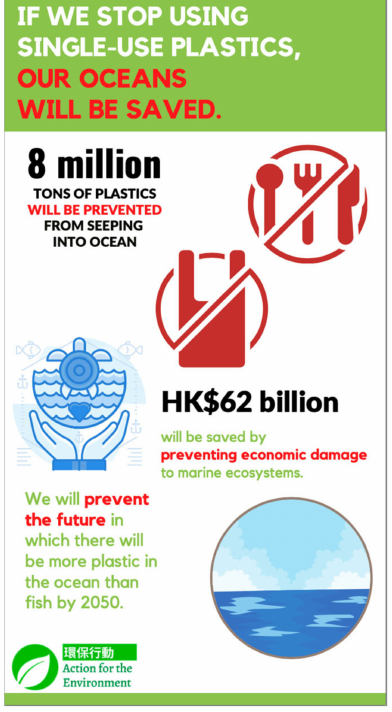
Figure A9. Example of condition 9: gain * infographic * NGO.